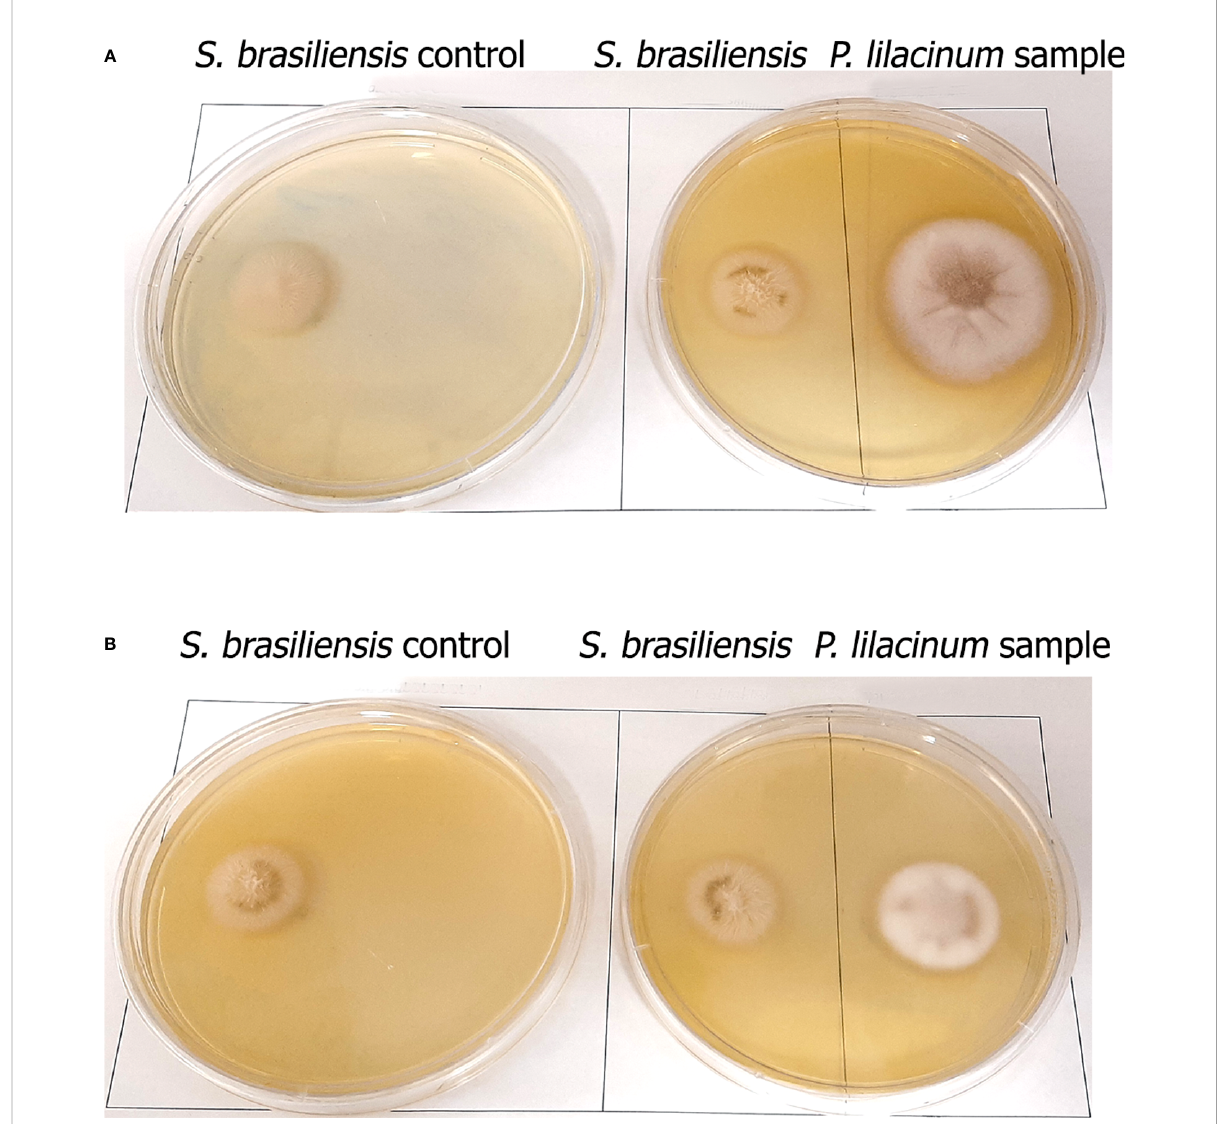
FIGURE 2 Antagonistic effects of Purpureocillium lilacinum isolates against Sporothrix brasiliensis in dual culture on the 7 th day of incubation. Control plates on the left showing S. brasiliensis colony; dual culture plates on the right showing growth inhibition of S. brasiliensis by P. lilacinum : (A) LTBBF-PL4 (21.73% inhibition); (B) LTBBF-PL9 (18.18%